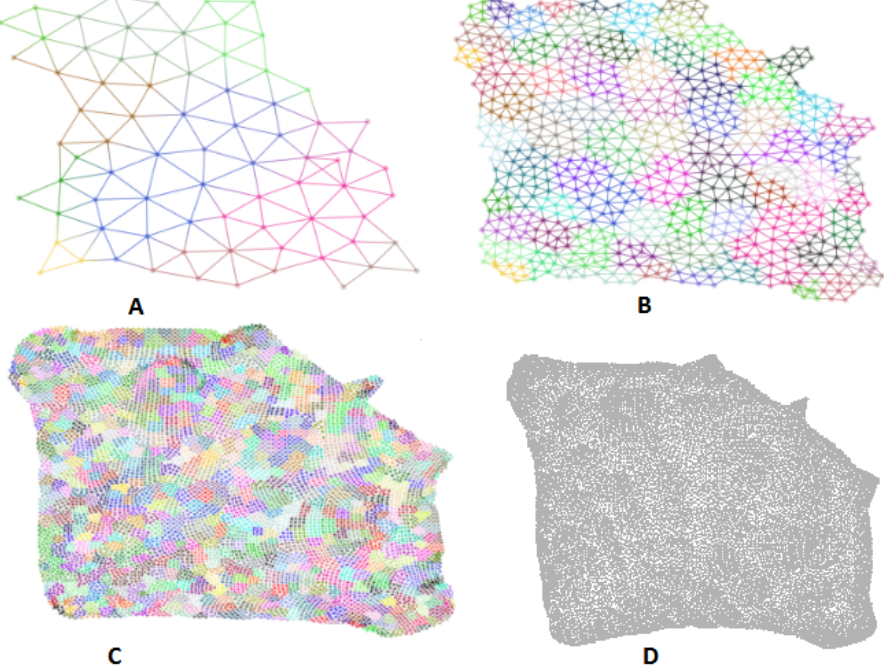
Figure 5. The crack layout results. ( A – C ) are three levels of coarsened graphs generated by our algorithm (graph nodes colored by cluster membership); ( D ) is the result from FM 3 implemented by ODGF